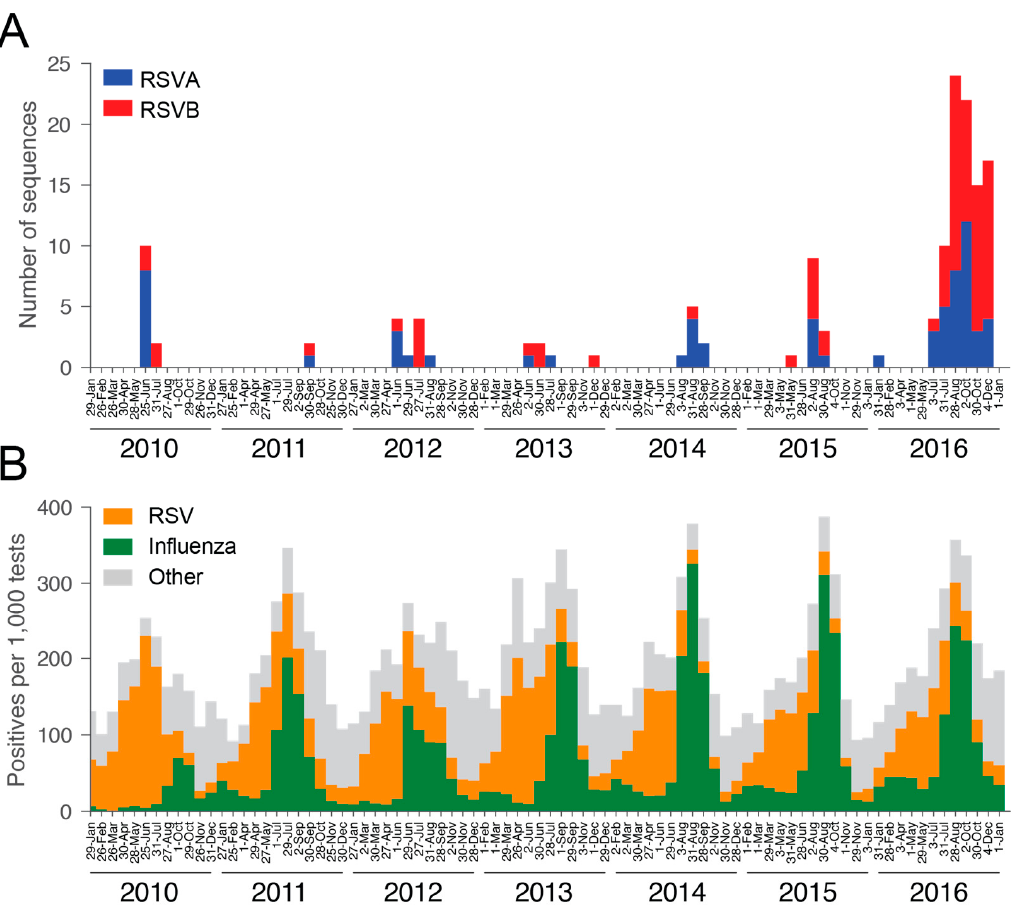
Figure 1. Incidence of respiratory syncytial virus (RSV) in New South Wales (NSW). ( A ) Number of RSV genome sequences per four ‐ week period: RSVA = blue, RSVB = red. ( B ) Number of positive samples per 1000 specimens reported across NSW per four ‐ week period: RSV = orange, Influenza = green, Other, including parainfluenza virus, adenovirus, and human metapneumovirus = grey.